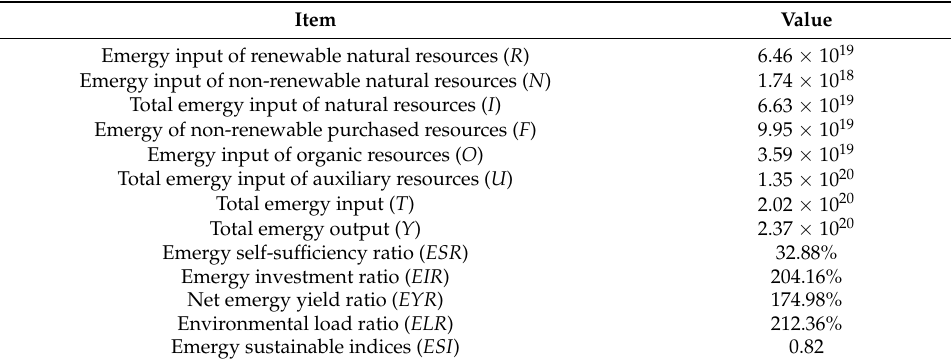
Table 7. Emergy evaluation index calculation of the village unit. Item